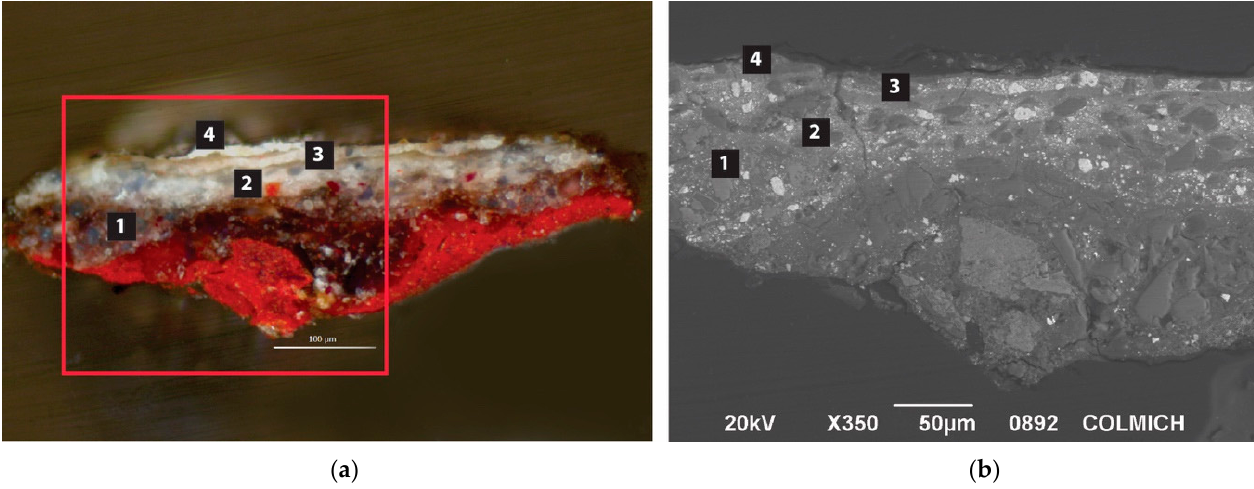
Figure 4. Cross-section from a cloud in La Asunci ó n . ( a ) Under the optical microscope (20 × ), it is possible to see the superposition of layers over a red lake as well as the yellow glazes in between the white layers. ( b ) The SEM image (350 × ) allows for a closer inspection of the particles. Images by LADiPA-COLMICH.